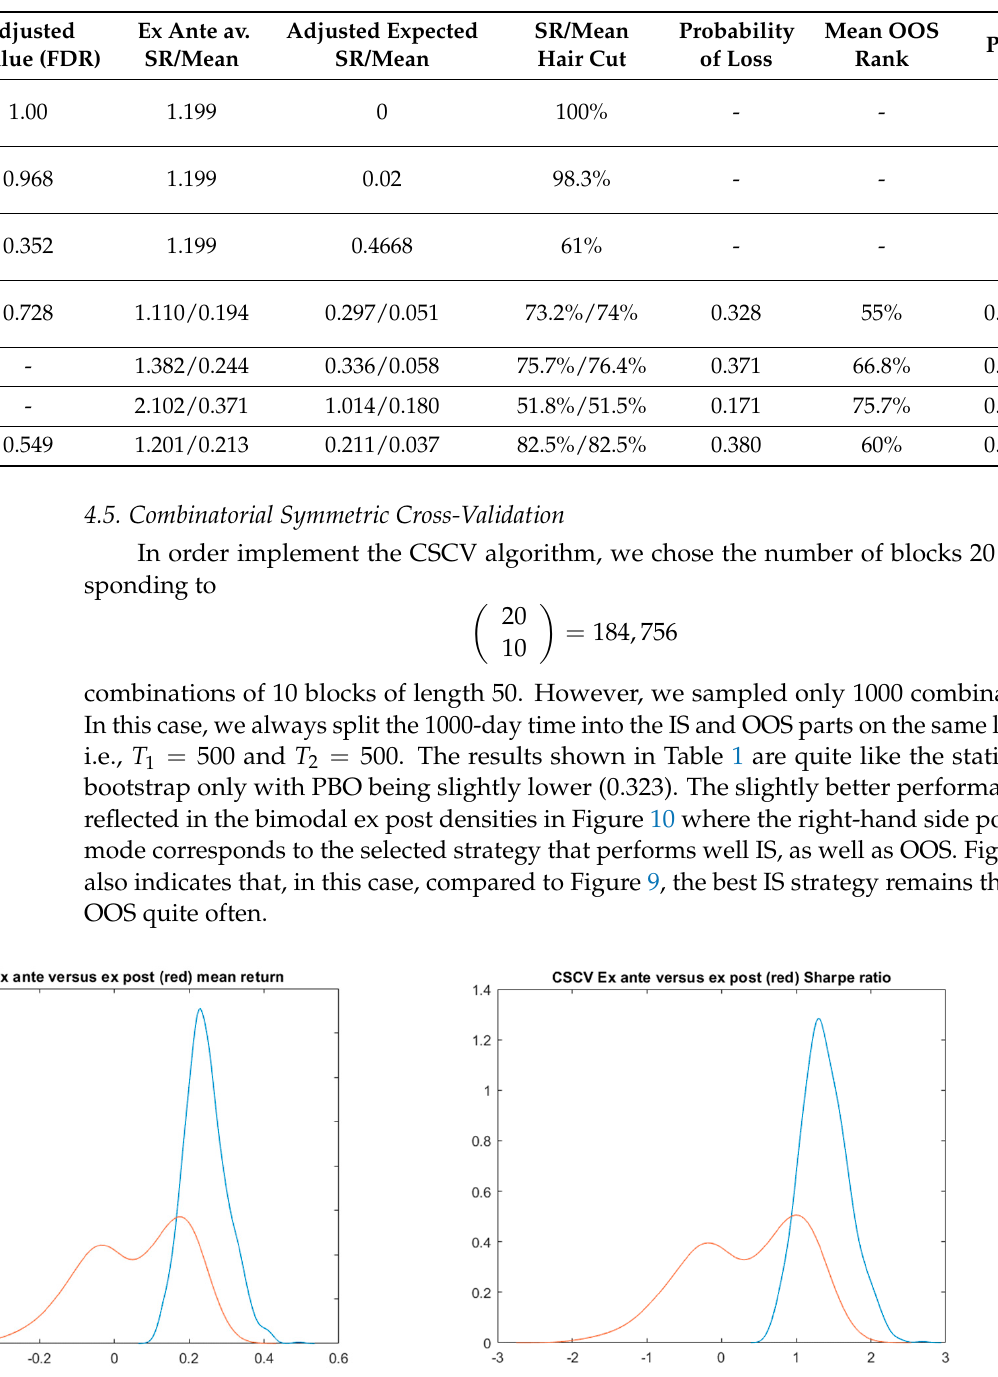
Figure 10. CSCV simulation of the ex ante (blue) and ex post (red) probability densities.